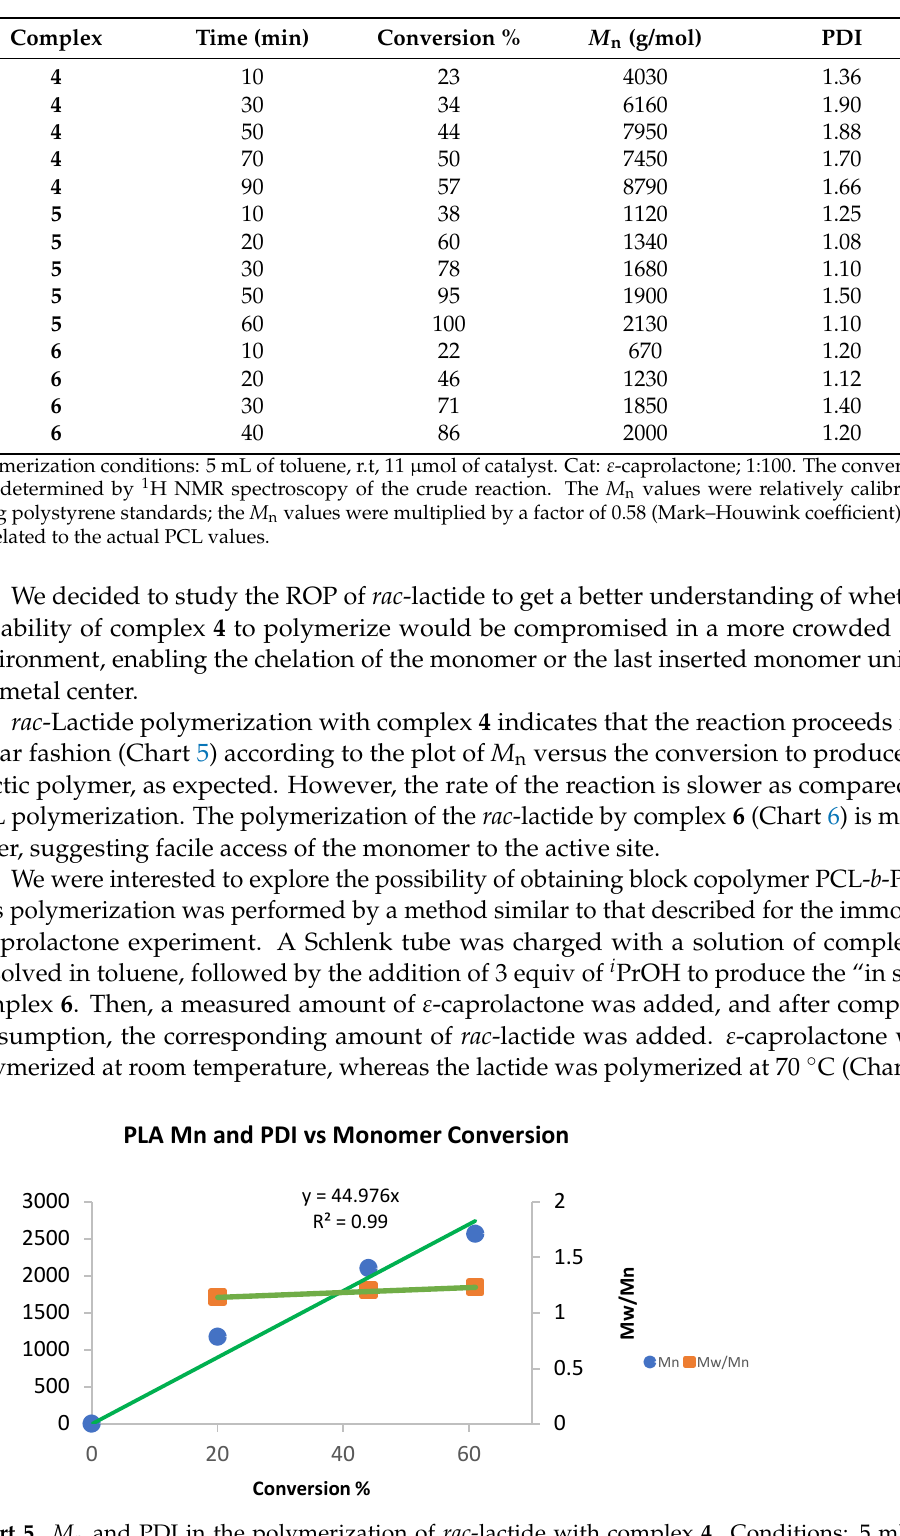
Table 4. Polymerization results for the ROP of ε -caprolactone mediated by complexes 4 – 6 .